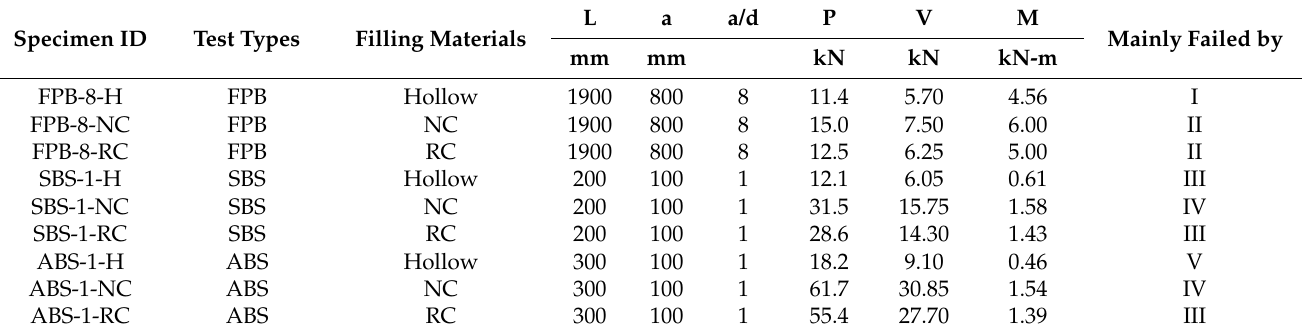
Table 2. Dimensions, capacities and failure modes of the test